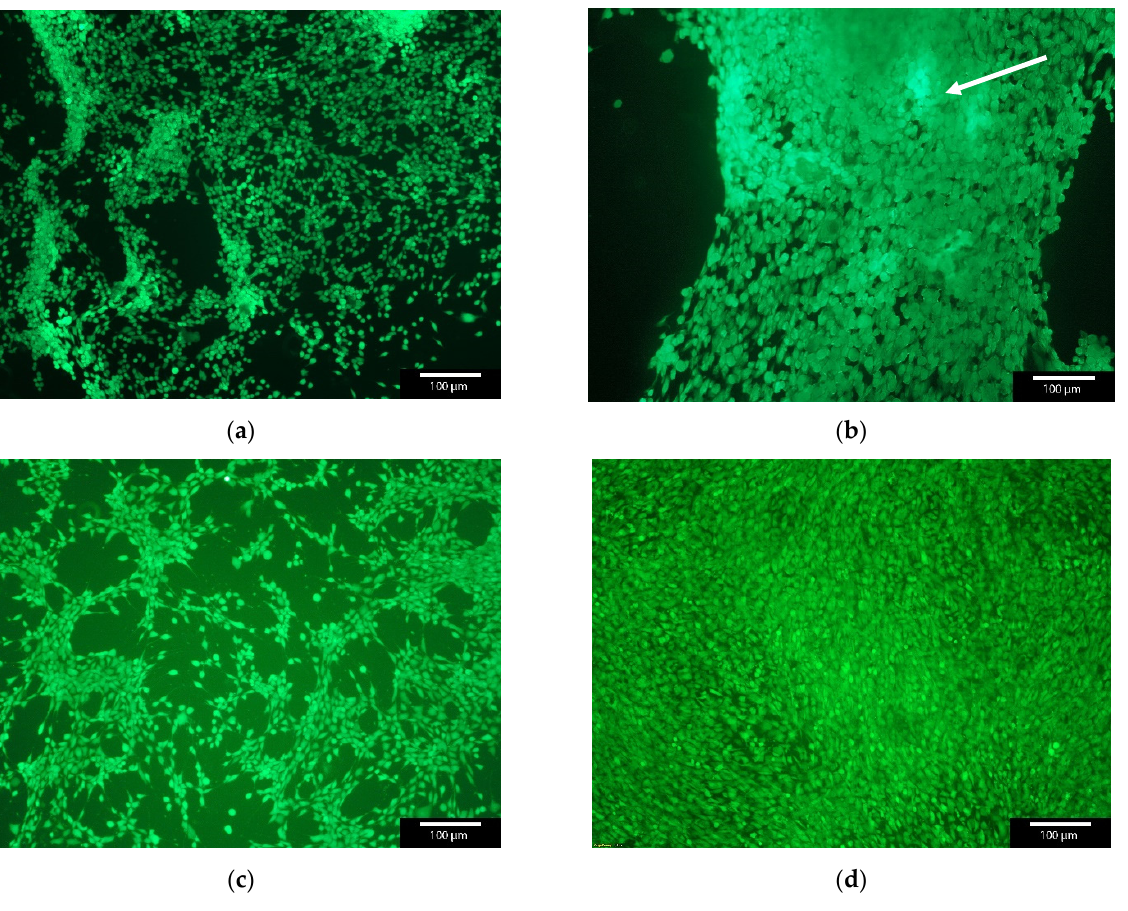
Figure 4. Live/Dead staining of MG-63 cells with GNPs versus MG-63 as control. The agglomerates of GNPs glowed slightly brighter in fluorescence microscopy (see white arrow); with GNPs after ( a ): 3 days; ( b ): 7 days; ( c ): control after 3 days; and ( d ): control after 7 days; green—living cells, red—dead cells. Images taken with Olympus BX-51 Fluorescence microscope, 5x magnification.